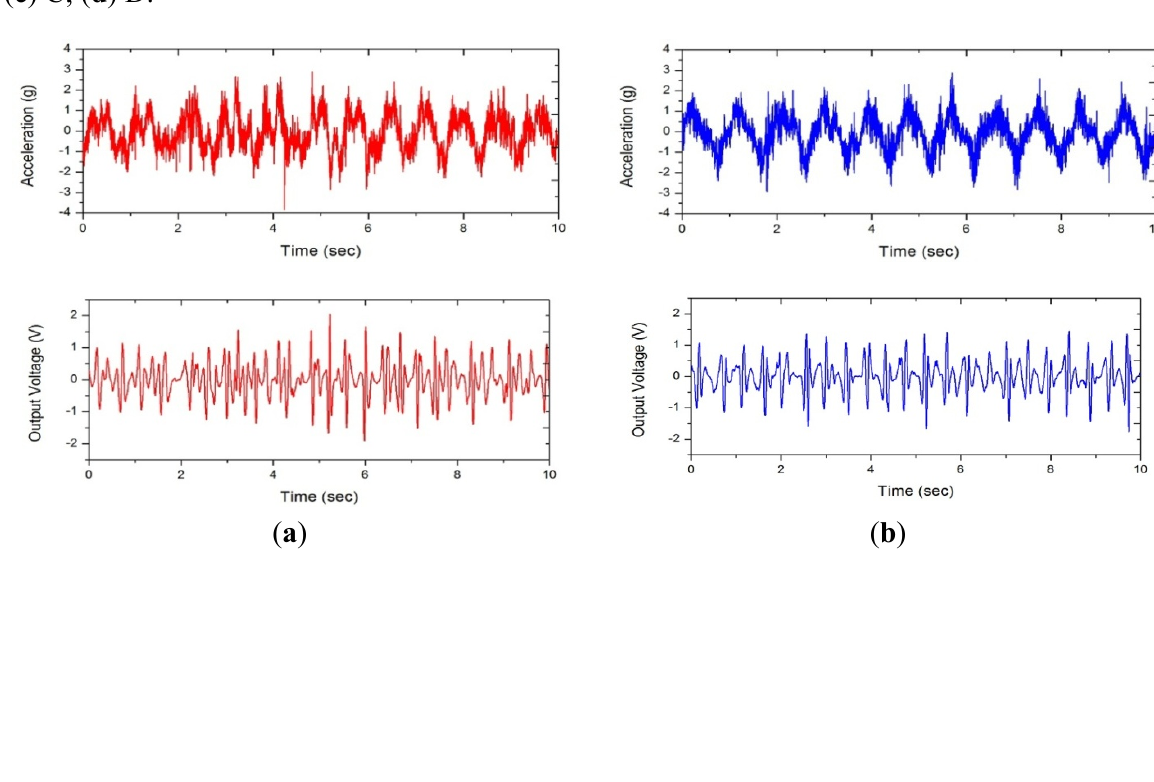
Figure 8. Acceleration and voltage waveform measured from each participant. ( a ) A; ( b ) B; ( c ) C; ( d )